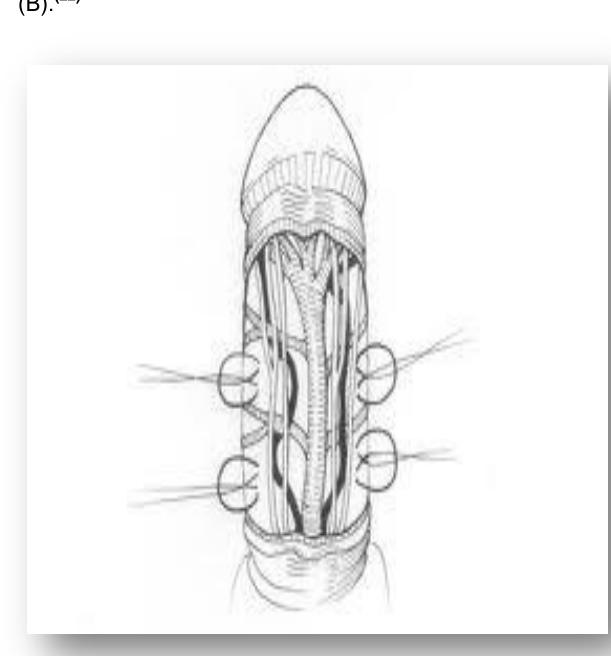
Figure 6: Dorsal penile plication at 2 and 10- o’clock position after neurovascular bundle mobilization.